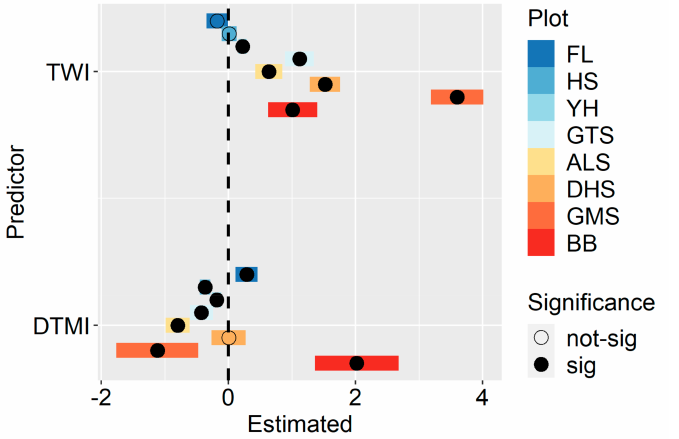
Figure 2. Results of the spatial simultaneous autoregressive error models (SARs). Colors represent forest plots from tropical (red) to temperate (blue) latitudes. The solid circle in the colored bar indicates significance at the 0.1 level. The black dotted line indicates no relationship. The colored bar on the left of the dotted line indicates a negative effect, and those on the right indicate a positive result. The X -axis is the estimated coefficient.